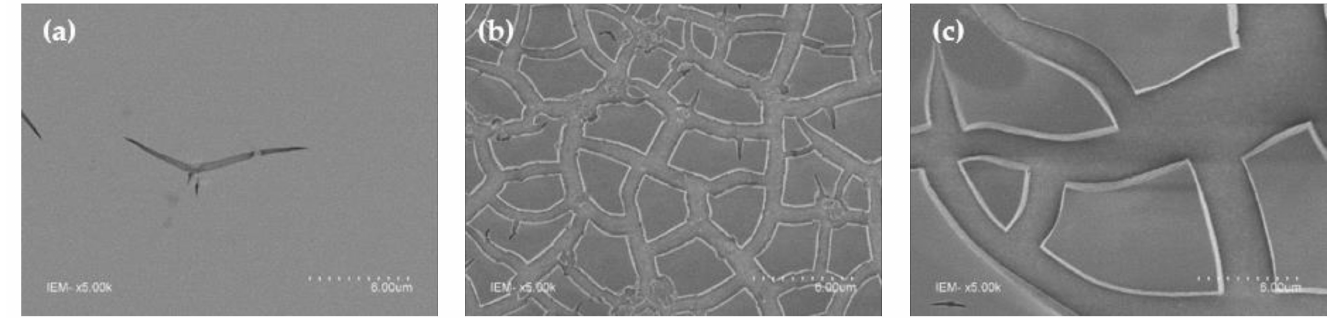
Figure 6. SEM pictures: ( a ) TiO 2 -GC; ( b ) TiO 2 -GB; and ( c ) TiO 2 -BIO. As a complement to the morphological investigation, AFM measurements in tapping mode have shown a root mean square roughness of 0.55 nm ± 0.11 nm for TiO 2 -GC, 0.89 nm ± 0.15 nm for TiO 2 -GB, and 3.24 nm ± 0.22 nm for TiO 2 -BIO, which confirms a flat and homogeneous surface apart from